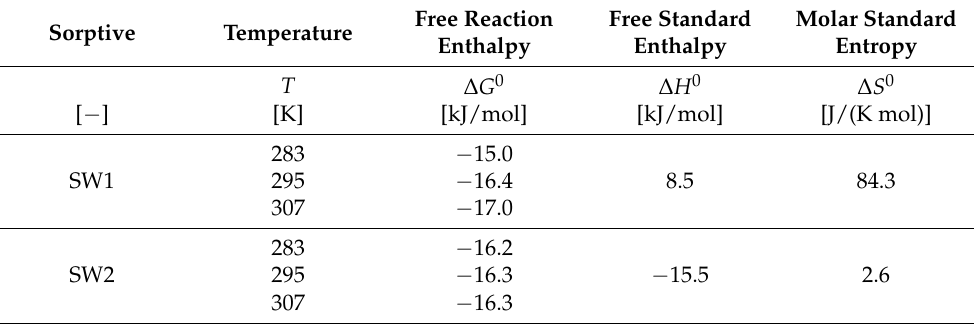
Table 6. Thermodynamic properties of CCP 20 after 20 h contact time with SW1 or SW2